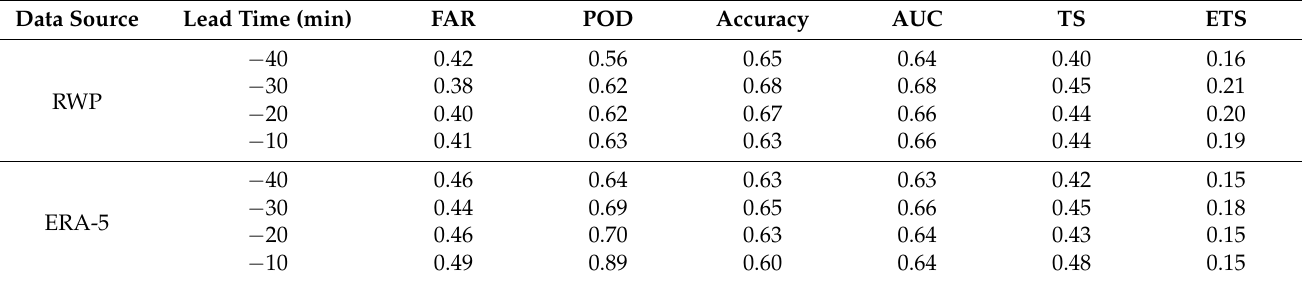
Table 4. Summary of the performance metrics of the RF model used to carry out the rainfall/non- rainfall forecast within 30 min before the rainfall onset at 23:20 BJT on 16 July